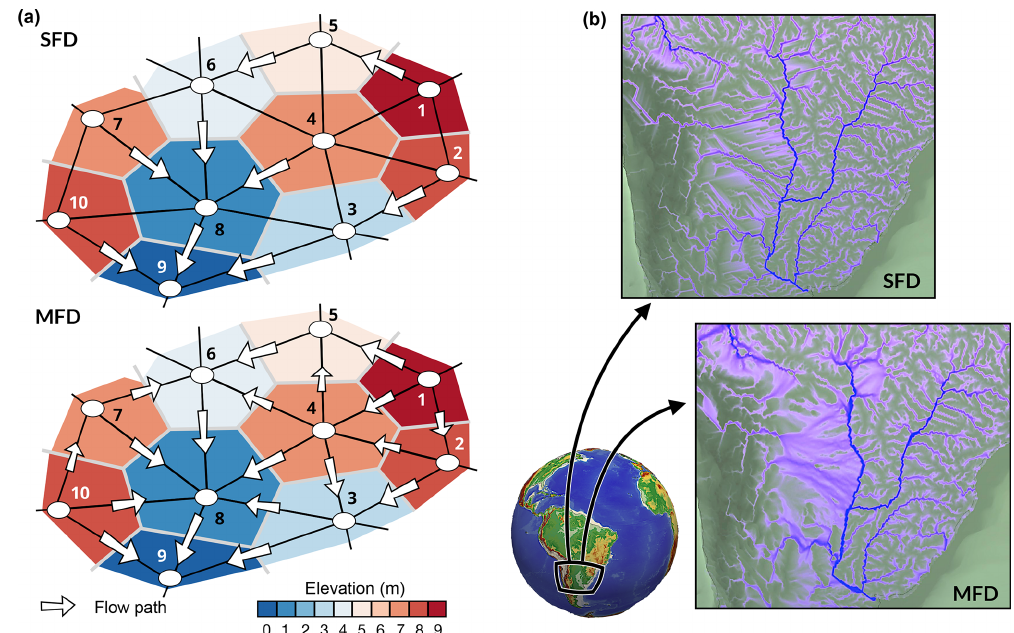
Figure 1. (a) Schematic diagram showing flow paths when considering a triangular irregular network composed of 10 vertices (node IDs are given for each case). Cells (i.e. Voronoi area defining the region of influence of each vertex) are coloured by elevation. Two cases are presented considering single flow direction (top sketch – SFD) and multiple flow direction (bottom sketch – MFD / D ∞ ). White arrows indicate flow direction and their sizes vary in proportion to slope (not at scale). Node numbers correspond to the subscripts in Eqs. (2) and (4). (b) Differences in calculated drainage area for a portion of South America from eSCAPE using the two flow direction